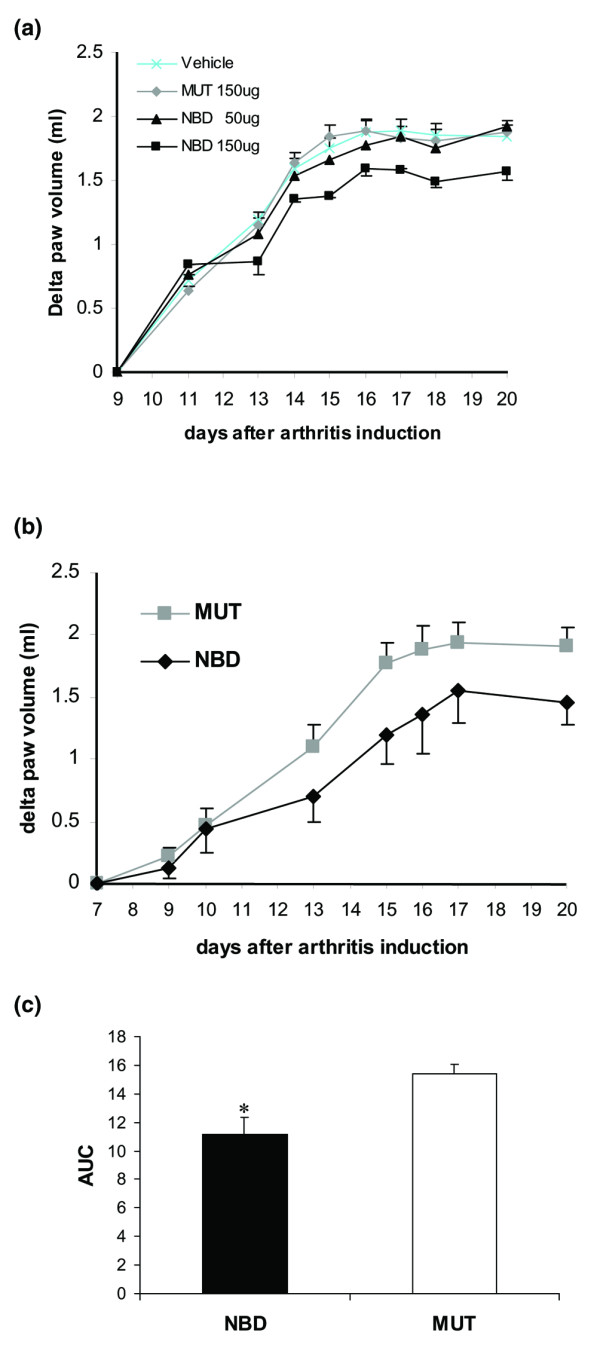
Intra-articular injection of the NBD peptide at the onset of disease ameliorates arthritis. (a) Dose-finding experiments. To determine the optimal dose of the NBD peptide for amelioration of arthritis, animals (n = 6/group) were treated intra-articularly at the onset of arthritis (day 10) and 2 days later (day 12) with either 50 or 150 μg of the peptides or vehicle. Paw swelling was measured by water displacement plethysmometry until the animals were sacrificed at day 20. Data represent mean ± standard error of the mean (SEM) paw swelling (p < 0.05). (b) To evaluate the effect of the NBD peptide on clinical arthritis compared with the mutant NBD (MUT) control peptide, animals (n = 15/group) were treated intra-articularly at the onset of arthritis (day 10) and 2 days later (day 12) with 150 μg of the peptides. Paw swelling was measured by water displacement plethysmometry until the animals were sacrificed at day 20. Data represent mean ± SEM paw swelling (p < 0.0001). (c) Results of the 'area under the curve' (AUC) calculation of the experiments displayed in (b) (*p < 0.0001).